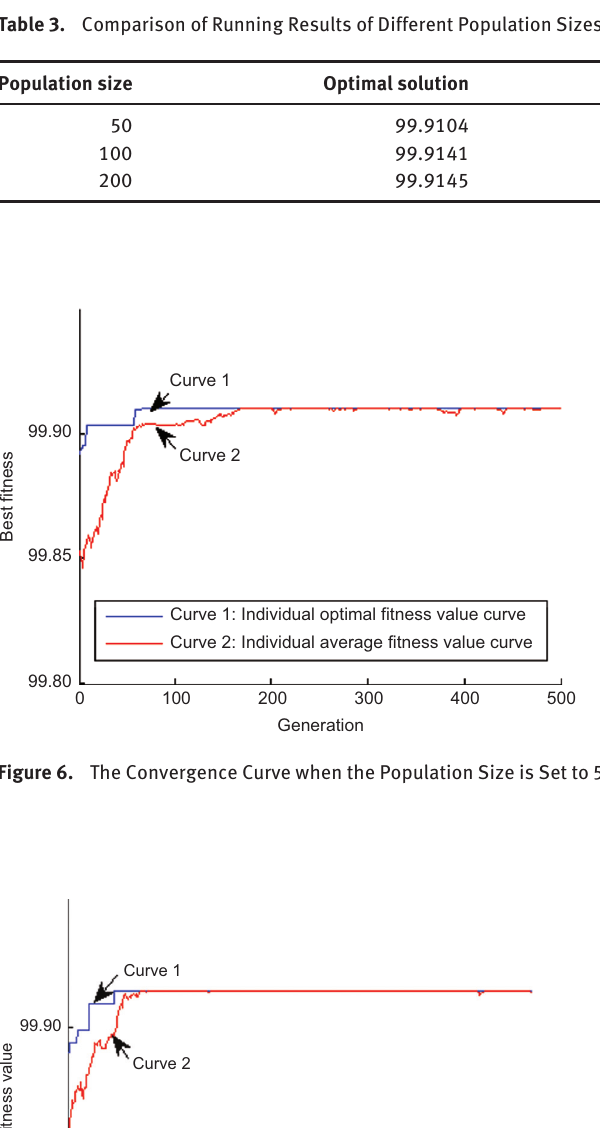
Curve 1: Individual optimal fitness value Curve 2: Individual average fitness value curve Figure 7. The Convergence Curve when the Population Size is Set to 100.